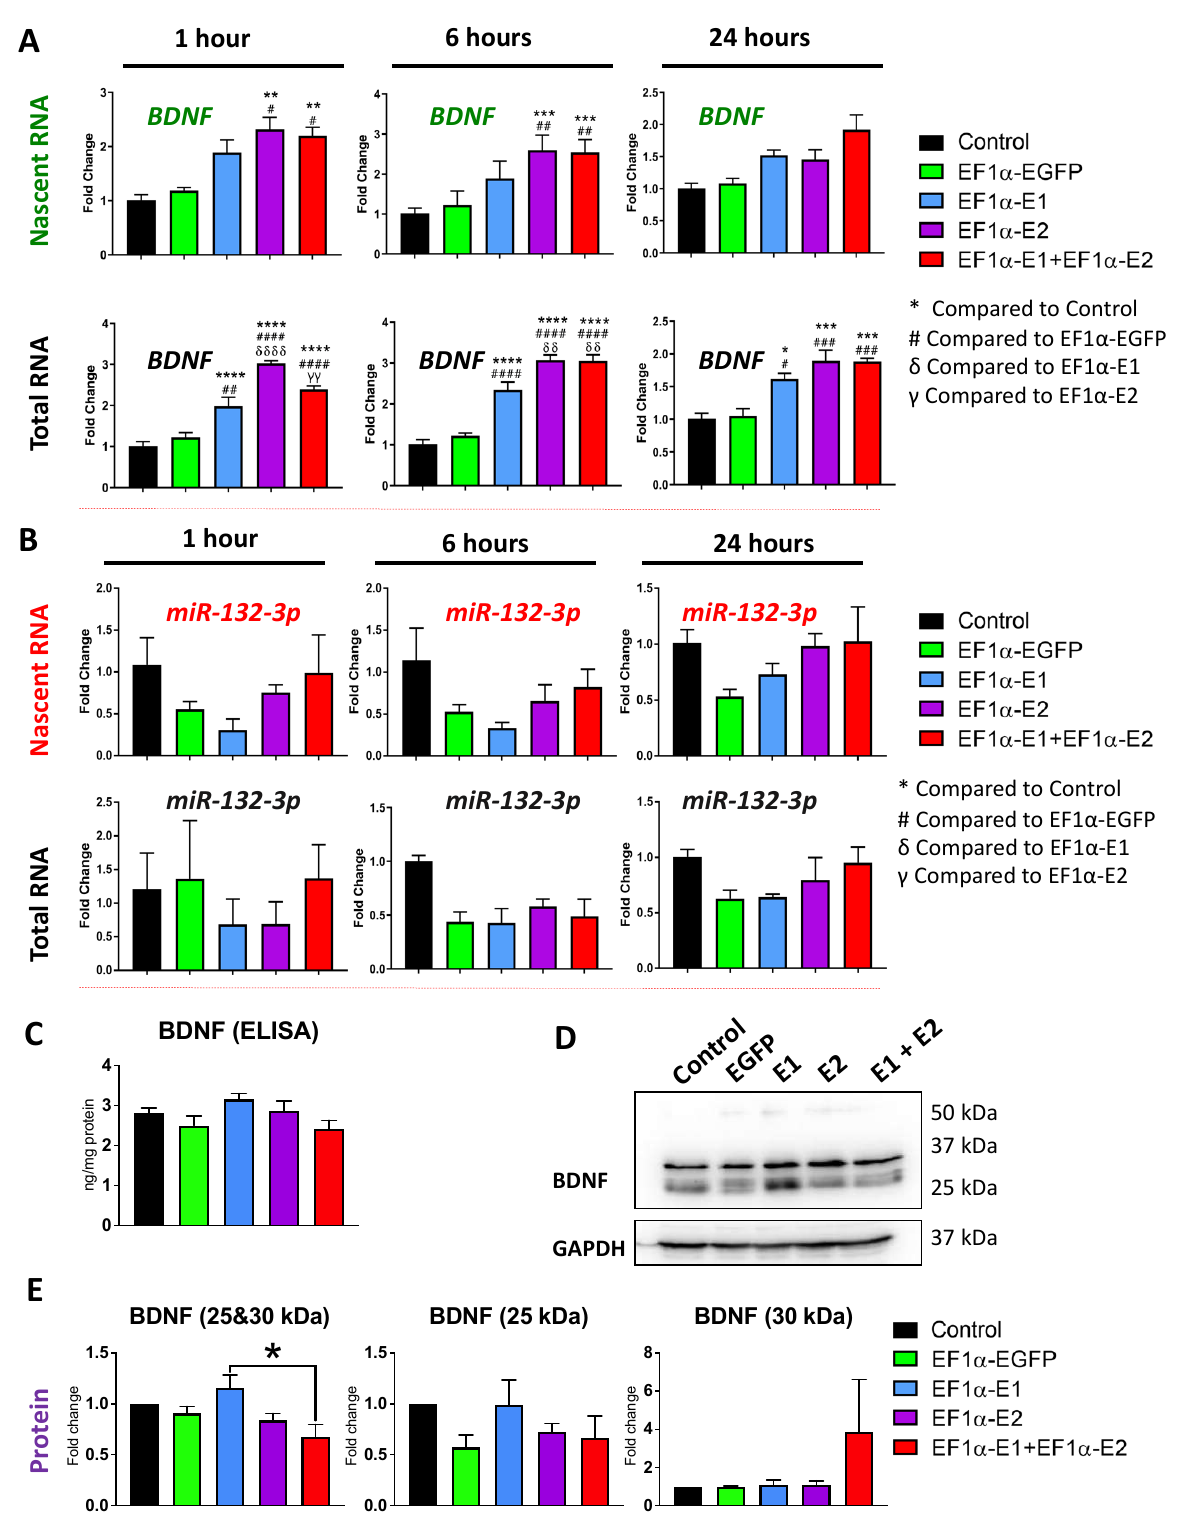
Figure 6. Expression of nascent and steady-state BDNF and miR-132-3p transcripts, and BDNF protein in Daoy cells transduced with lentiviral vectors expressing MeCP2 isoforms. Nascent RNA was prepared from cells labelled with EU for 1 h, 6 h, and 24 h. Total RNA was prepared from unlabeled cells collected at the same time points. Gene expression was analyzed by RT-PCR for ( A ) BDNF transcripts, with GAPDH as the housekeeping gene, and ( B ) miR-132-3p transcripts with microRNA U6 as the housekeeping control. For A and B, the C T values were normalized to the housekeeping gene, and fold change was determined relative to average non-transduced control cells. n = 3, and data are reported as mean ± SEM. Fold change values were analyzed by two-way ANOVA followed by Tukey’s multiple comparisons test, *: p < 0.05, **: p < 0.01, ***: p < 0.001, and ****: p < 0.0001 (* indicates the difference from control; # indicates the difference from EF1 α -EGFP; δ indicates the difference from EF1 α -E1; γ indicates the difference from EF1 α -E2, respectively). ( C ) ELISA experiments for BDNF protein in analyzed total cell extracts from non-transduced Daoy